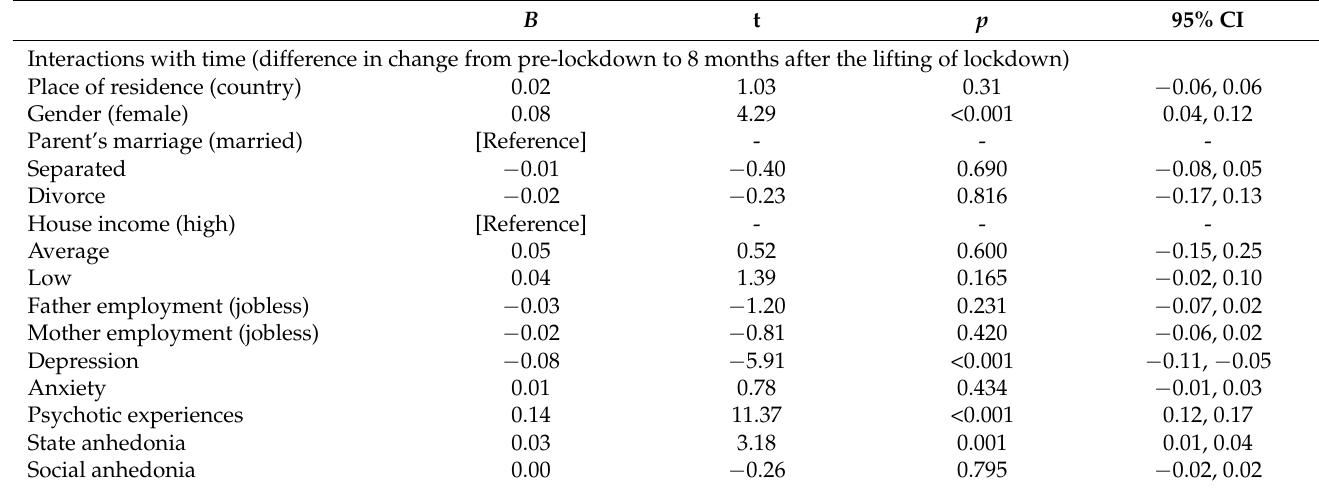
Table 2. Mixed model predicting an increase in sexual abuse from before to after